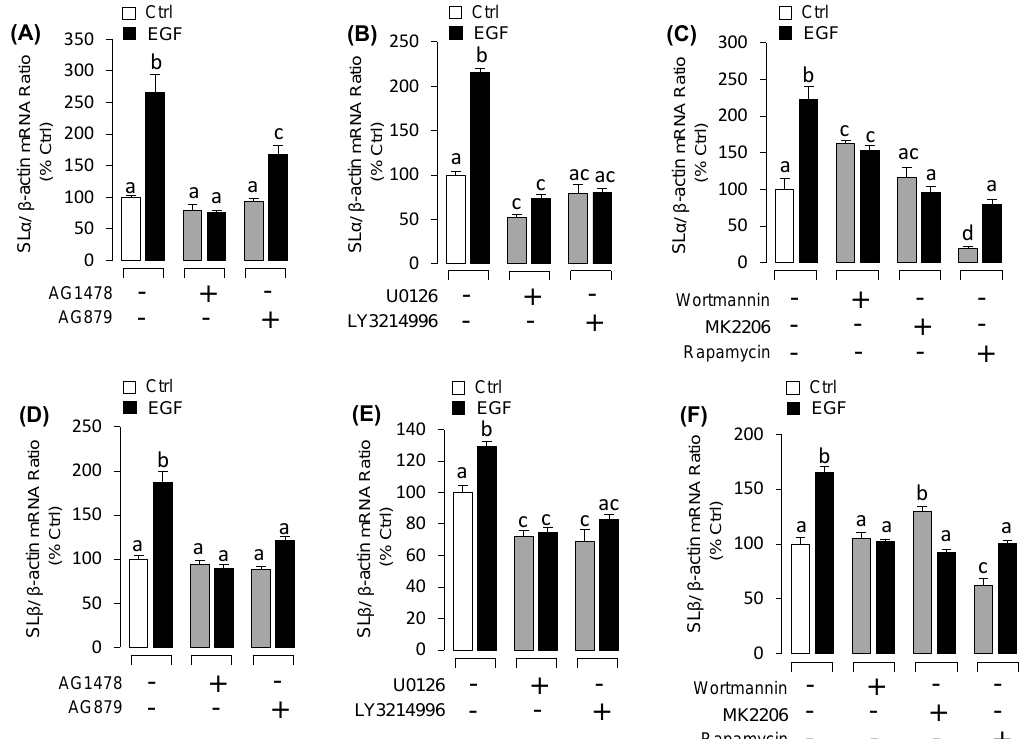
Figure 5. Receptor specificity and post-receptor signal pathways of EGF-induced SL α and SL β mRNA expression. Receptor specificity for SL α ( A ) and SL β ( D ) regulation by EGF. In this experiment, grass carp pituitary cells were treated for 48-h with EGF (50 nM) in the presence or absence of ErbB1 inhibitor AG1478 (5 µ M) or ErbB2 inhibitor AG879 (5 µ M). The e ff ects of 48-h co-treatment with MEK 1 / 2 inhibitor U0126 (5 µ M) or ERK 1 / 2 inhibitor LY3214996 (5 µ M) on EGF (50 nM)-induced SL α ( B ) and SL β ( E ) mRNA expression, respectively. The e ff ects of 48-h co-treatment with PI 3 K inhibitor wortmannin (5 µ M), Akt inhibitor MK2206 (5 µ M) or mTOR inhibitor rapamycin (5 µ M) on EGF (50 nM)-induced SL α ( C ) and SL β ( F ) mRNA expression, respectively. After drug treatment, the total RNA was collected and prepared for real-time PCR of SL α and SL β mRNA expression. Data presented are expressed as mean ± SEM ( n = 4). The di ff erent letters represent a significant di ff erence at p < 0.05 between groups (ANOVA followed by a Dunnett